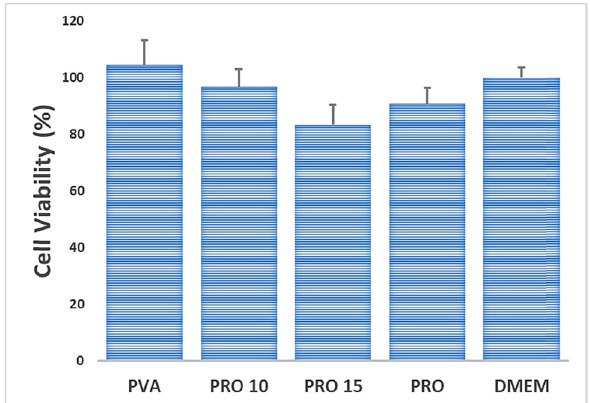
Figure 7: In vitro cell proliferation results of PVA, PRO 10, PRO 15, pure PRO, and